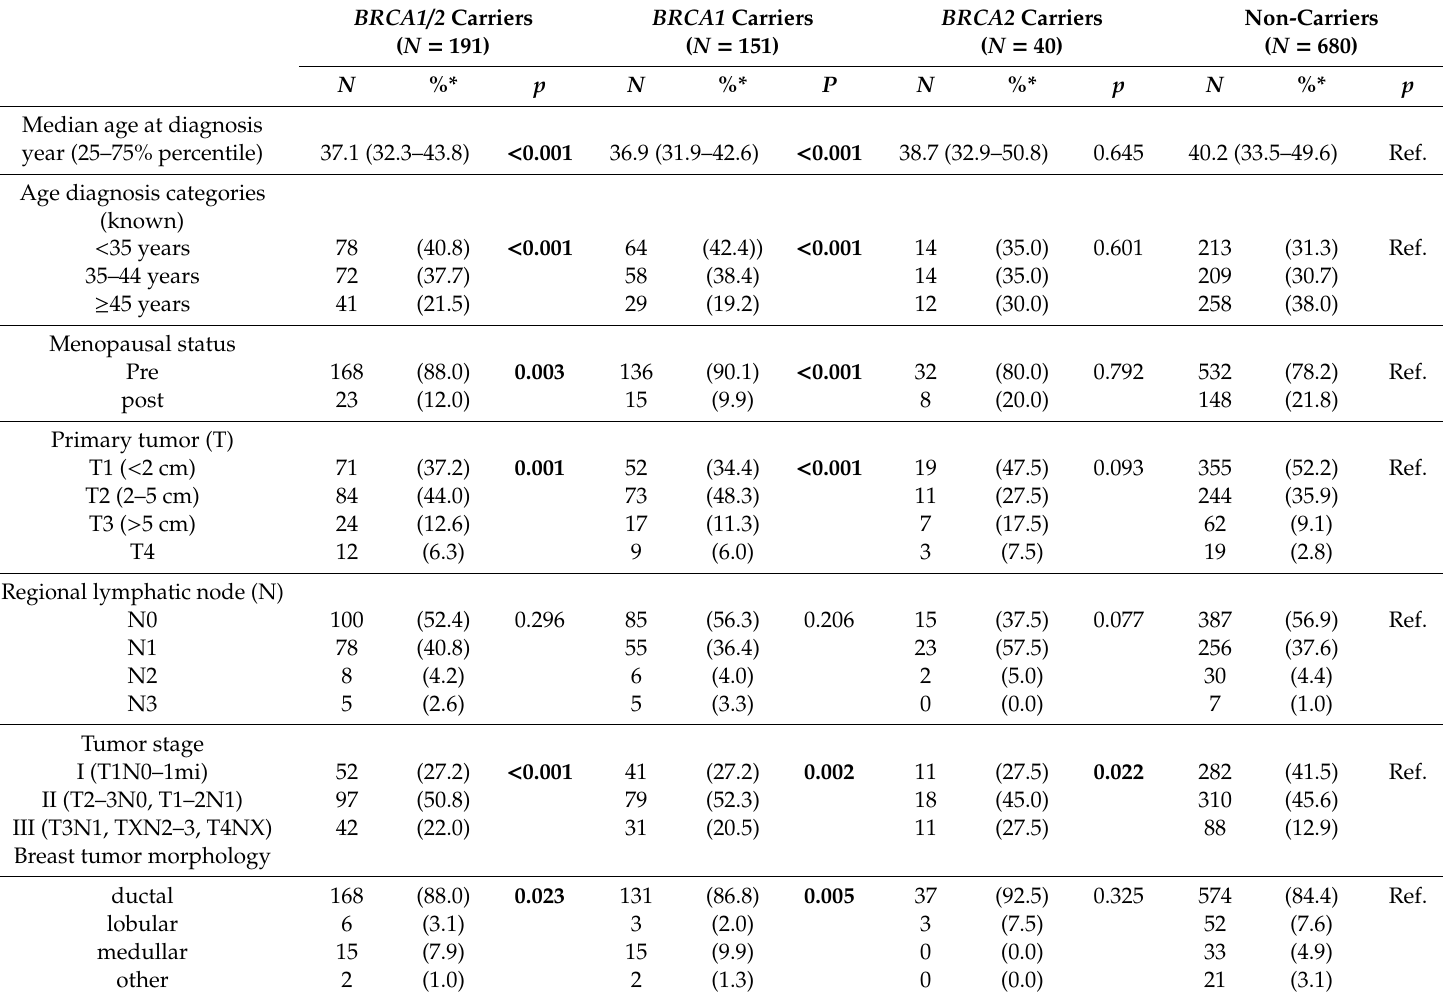
Table 1. Clinicopathological characteristics of BRCA1 / BRCA2 mutation carriers (together and separately) and non-carriers of mutations in cancer-susceptibility genes for whom complete clinicopathological data were available for subsequent univariate and multivariable